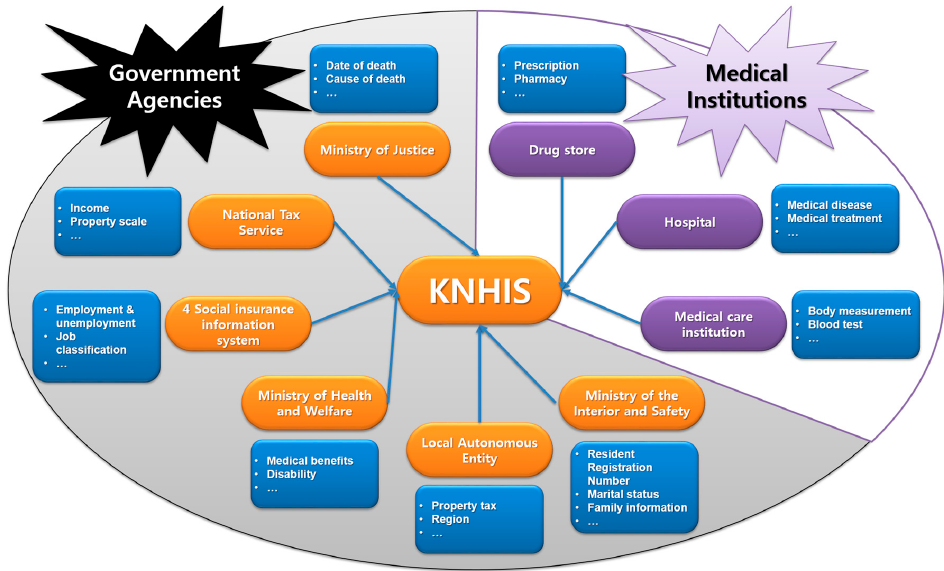
Figure 2. Personal medical data collection of Korea National Health Insurance Service (KNHIS) cooperating with other institutions.